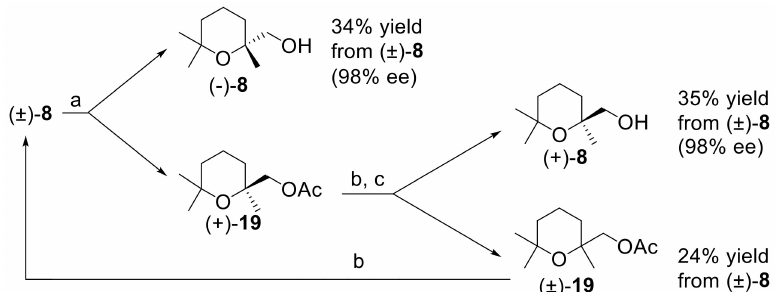
Figure 7. Large-scale resolution procedure of racemic 2,6,6-trimethyltetrahydro-2 H -pyran-2-yl)methanol 8 . Reagents and conditions: ( a ) Novozym ® 435 lipase, t -BuOMe/vinyl acetate 5:1, rt; ( b ) NaOH/MeOH, reflux, 1 h; ( c ) lipase AK, t -BuOMe/vinyl acetate 5:1,